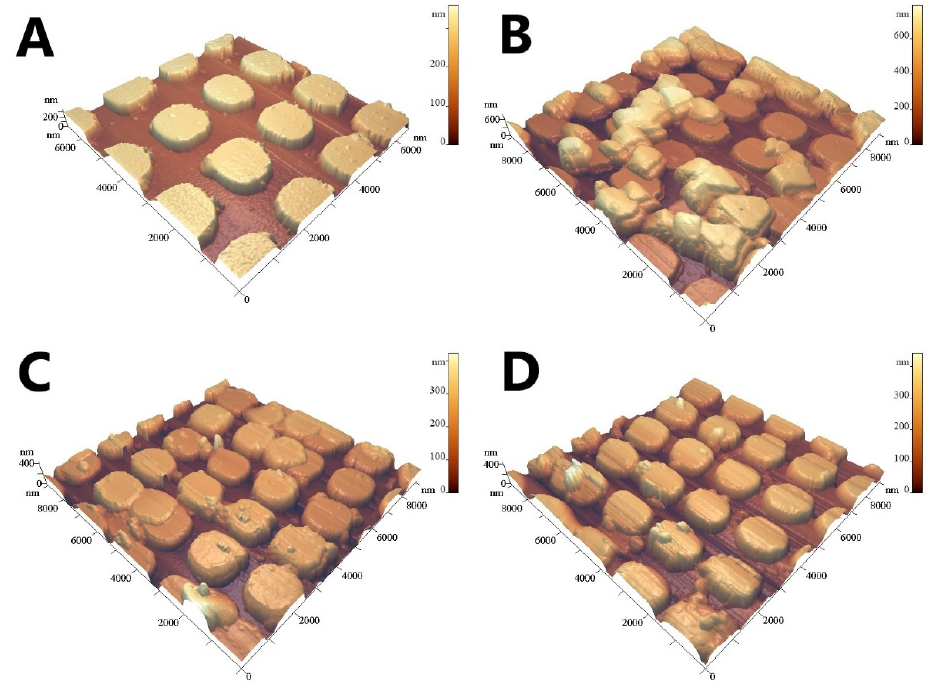
Figure 7. AFM images of the lithographic SERS structures with the aptamer SH-RBD-1C-Cy3. ( A ) The structure with the control influenza A virus. ( B – D ) The structures with SARS-CoV-2.